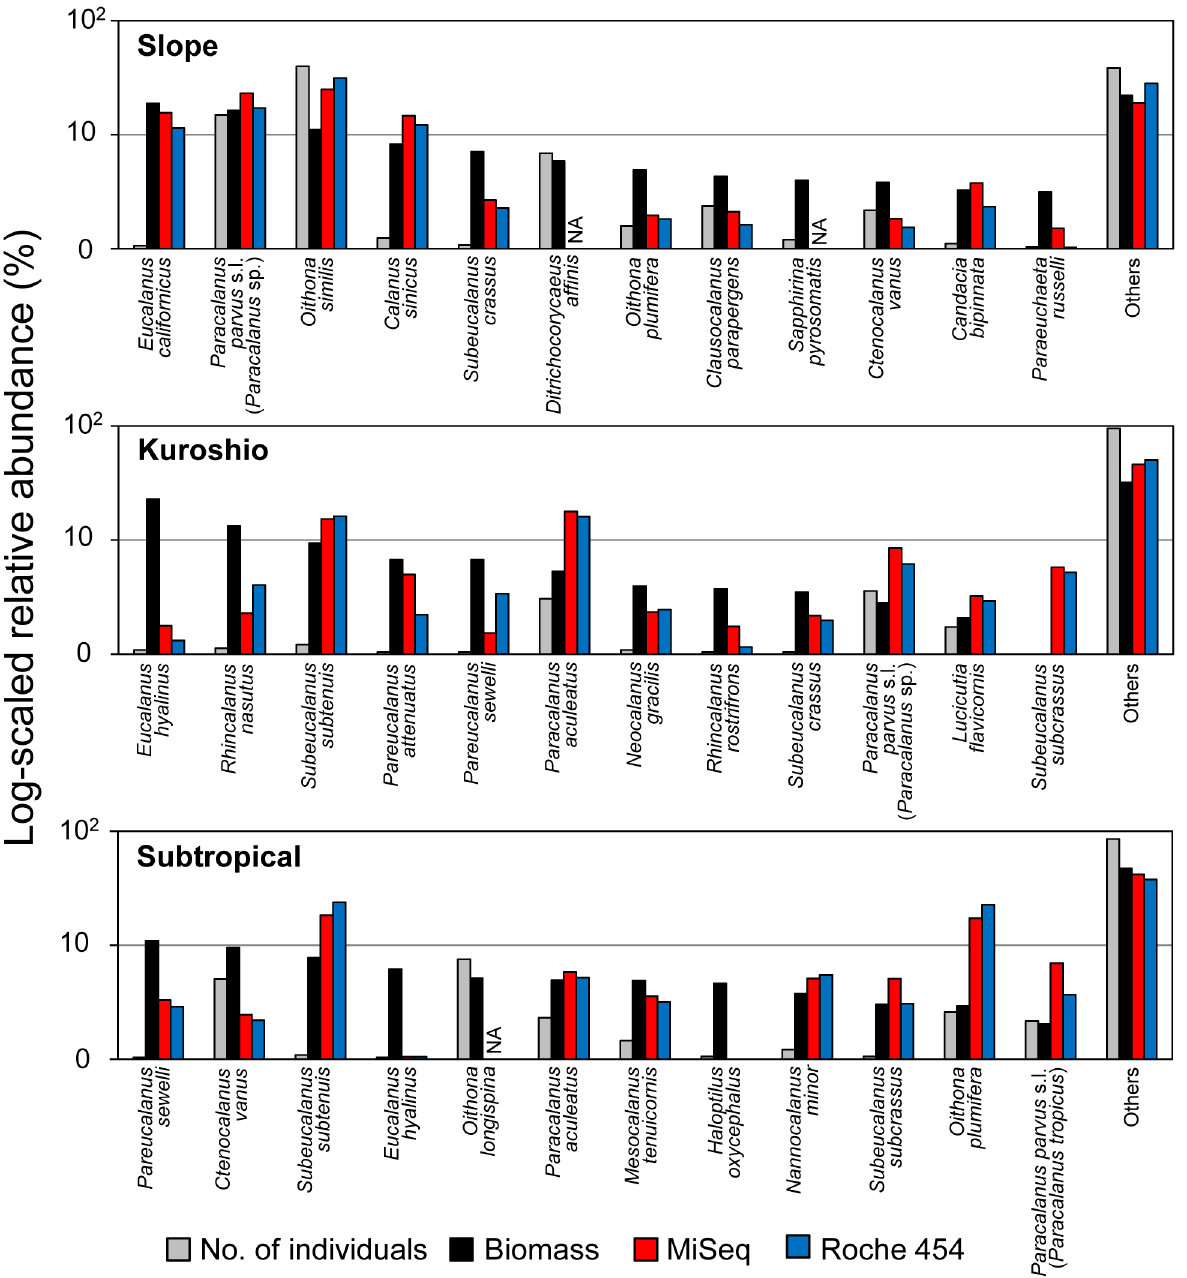
Fig 5. Proportions of dominant species and MOTUs at each station. MOTUs at a 99% similaritythreshold were assignedto species. NA represents MOTUs whichwere not assignedto any copepodspecies( < 99% similarity to publicdatabase). The proportionsof numbers of individuals,biomass,and sequence reads are presentedas log x+1 -transformed values.The morphological species Paracalanusparvus s.l. was further classifiedinto Paracalanus sp. (Slopeand Kuroshio)or P . tropicus (Subtropical) in the metagenetic analysis,accordingto Hidakaet al.